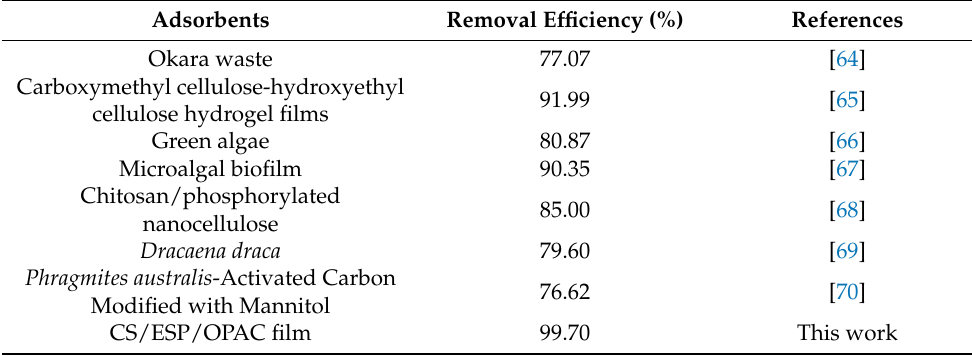
Table 2. The comparison of removal efficiency of various biosorbents for Cd 2+ .